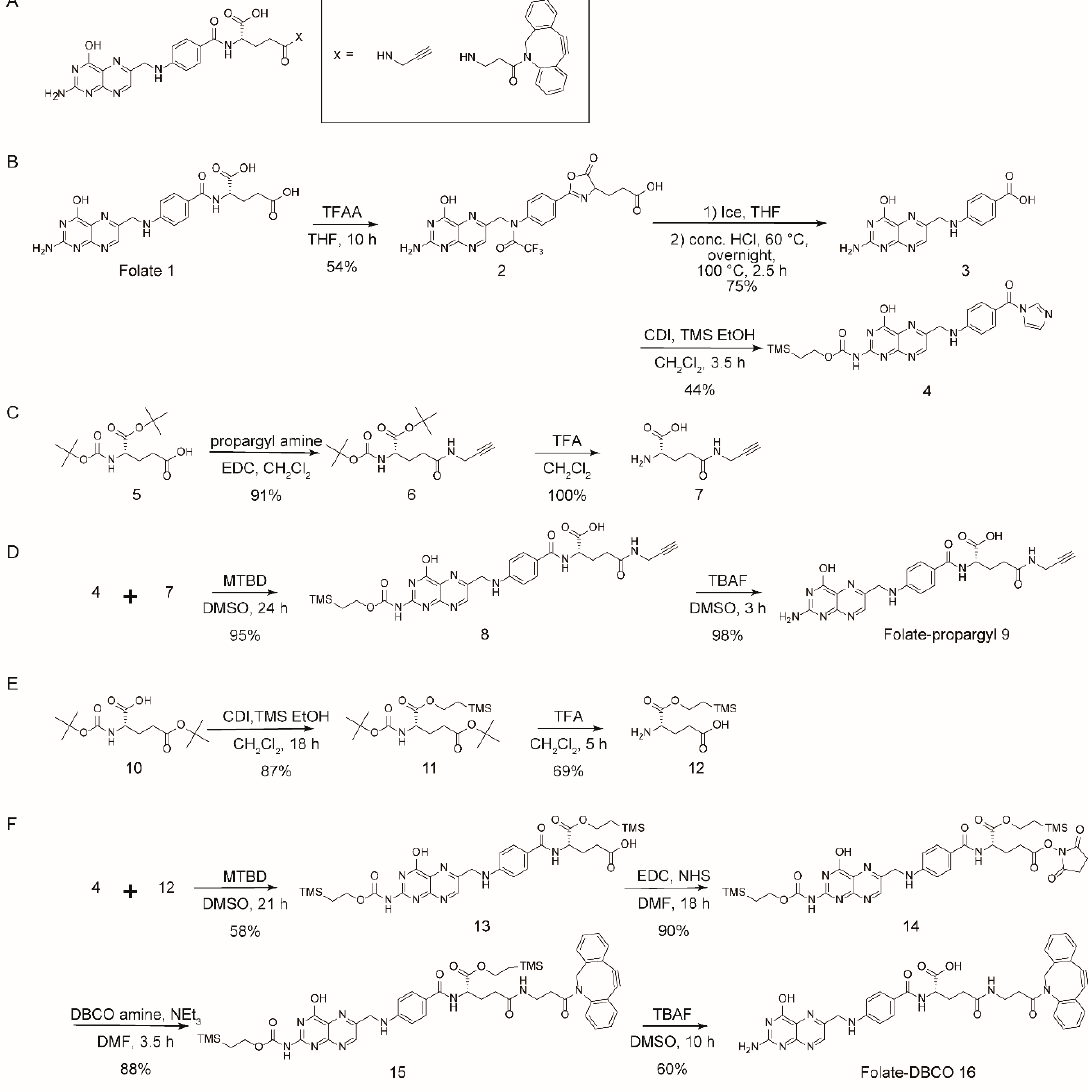
Figure 6. Structures and syntheses of folate derivatives. ( A ) Structure of folate is modified with group ‘X’, where X = propargyl or DBCO (the chemical structures was drawn in black box). The chemical structures of propargyl and DBCO are drawn in black box. ( B ) Synthesis of pteroic acid, ( C ) synthesis of γ -propargyl glutamic acid, ( D ) synthesis of folate-propargyl, ( E ) synthesis of silyl protected glutamic acid and ( F ) synthesis of